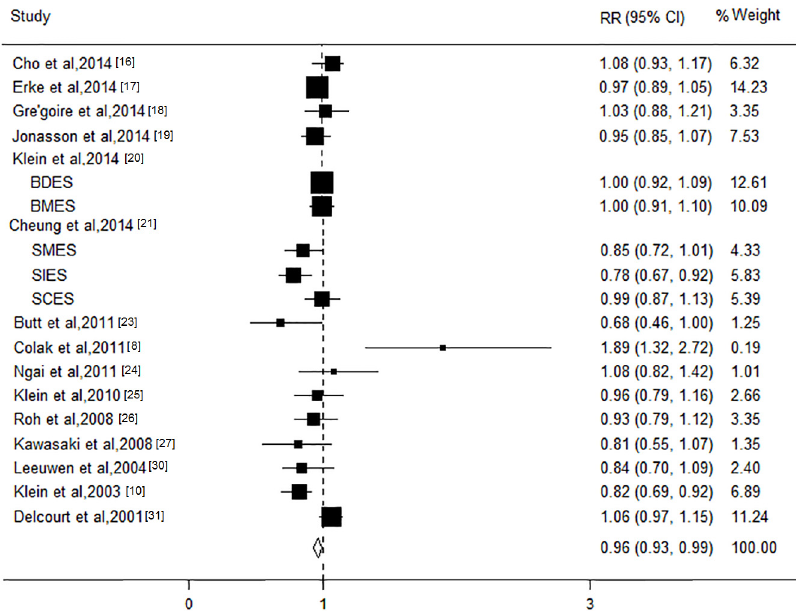
Figure 4. Forest plot on the associations between the total cholesterol level and age ‐ related macular degeneration. The boxes and lines indicate the relative risks (RRs) and their 95% confidence intervals (CIs) on a log scale for each study. The pooled relative risk is represented by a diamond. The size of the black squares indicates the relative weight of each estimate.